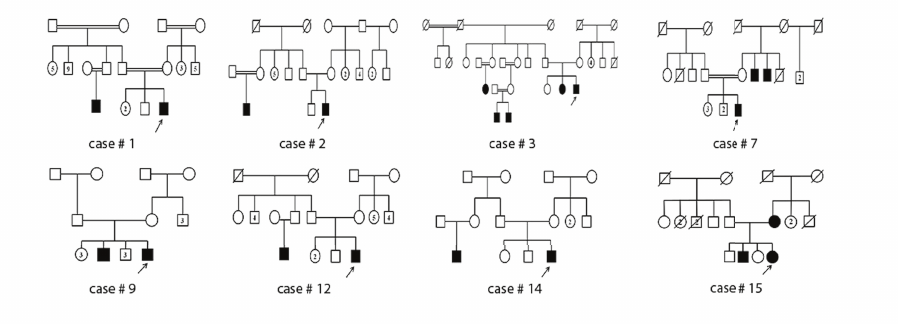
Figure 2. The pedigree drawings of eight cases with combined inferior feather-shape lens opacity and keratoconus. The number assigned to each case corresponds to the patients’ numbers provided in Tables 1 and